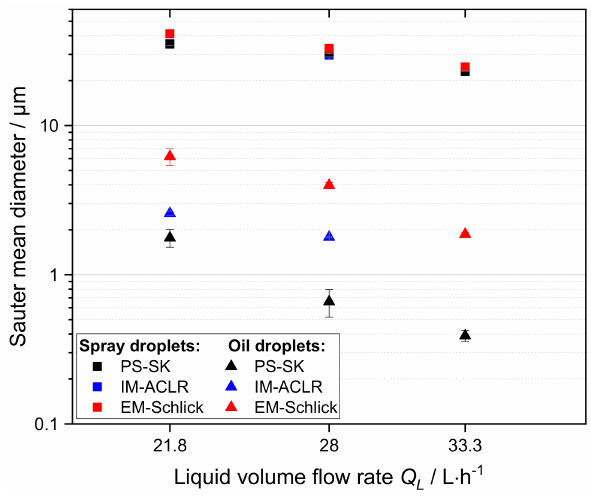
Figure 3. Sauter mean diameter of spray droplets and oil droplets in emulsions after atomization at different volume flow rates at the process conditions summarized in Table 1. PS-SK: Pressure swirl nozzle; IM-ACLR: Internal mixing twin-fluid nozzle; EM-Schlick: External mixing twin-fluid